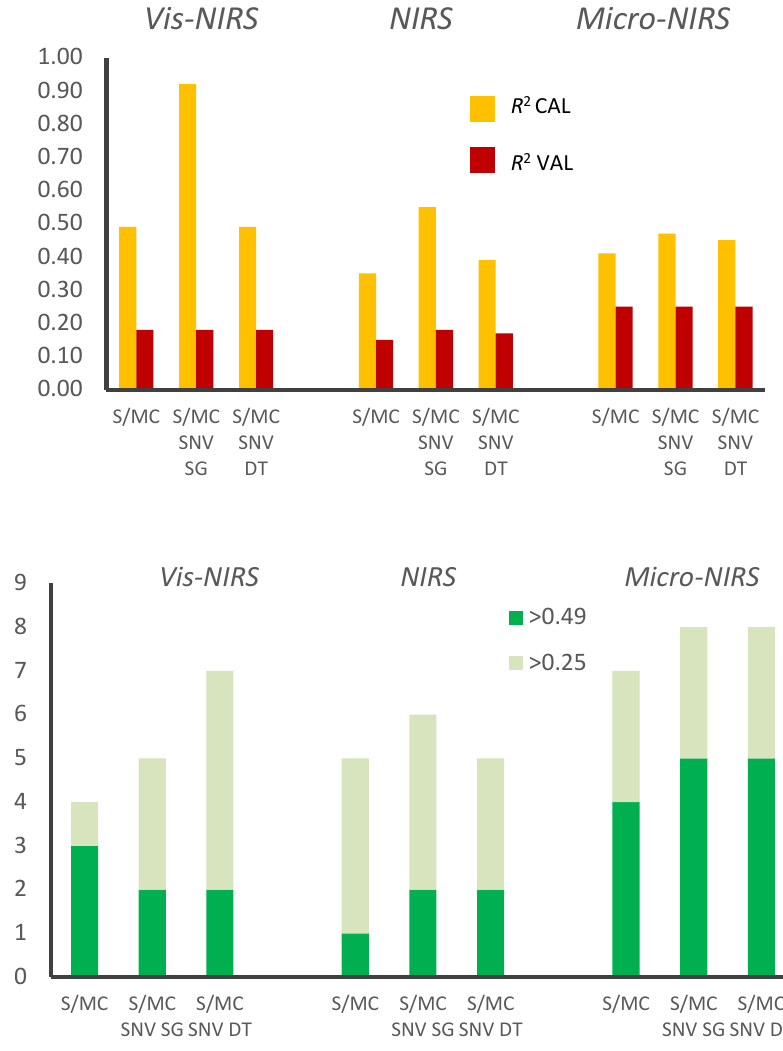
Figure 2. Average determination coe ffi cients (top) of calibration ( R 2 CAL ) and external validation ( R 2 VAL ), and the number of minerals out of 20 (bottom) with R 2 VAL > 0.49 ( r > 0.70) and 0.25 ( r > 0.50) obtained with the three infrared spectrometers and the three combinations of mathematical pretreatments of the absorbance values of the spectra. X-MC, spectra standardization and mean-centering; SNV, standard normal variate; SC, Savitzky–Golay first- and second-order derivatives with a third-order of polynomial; DT,